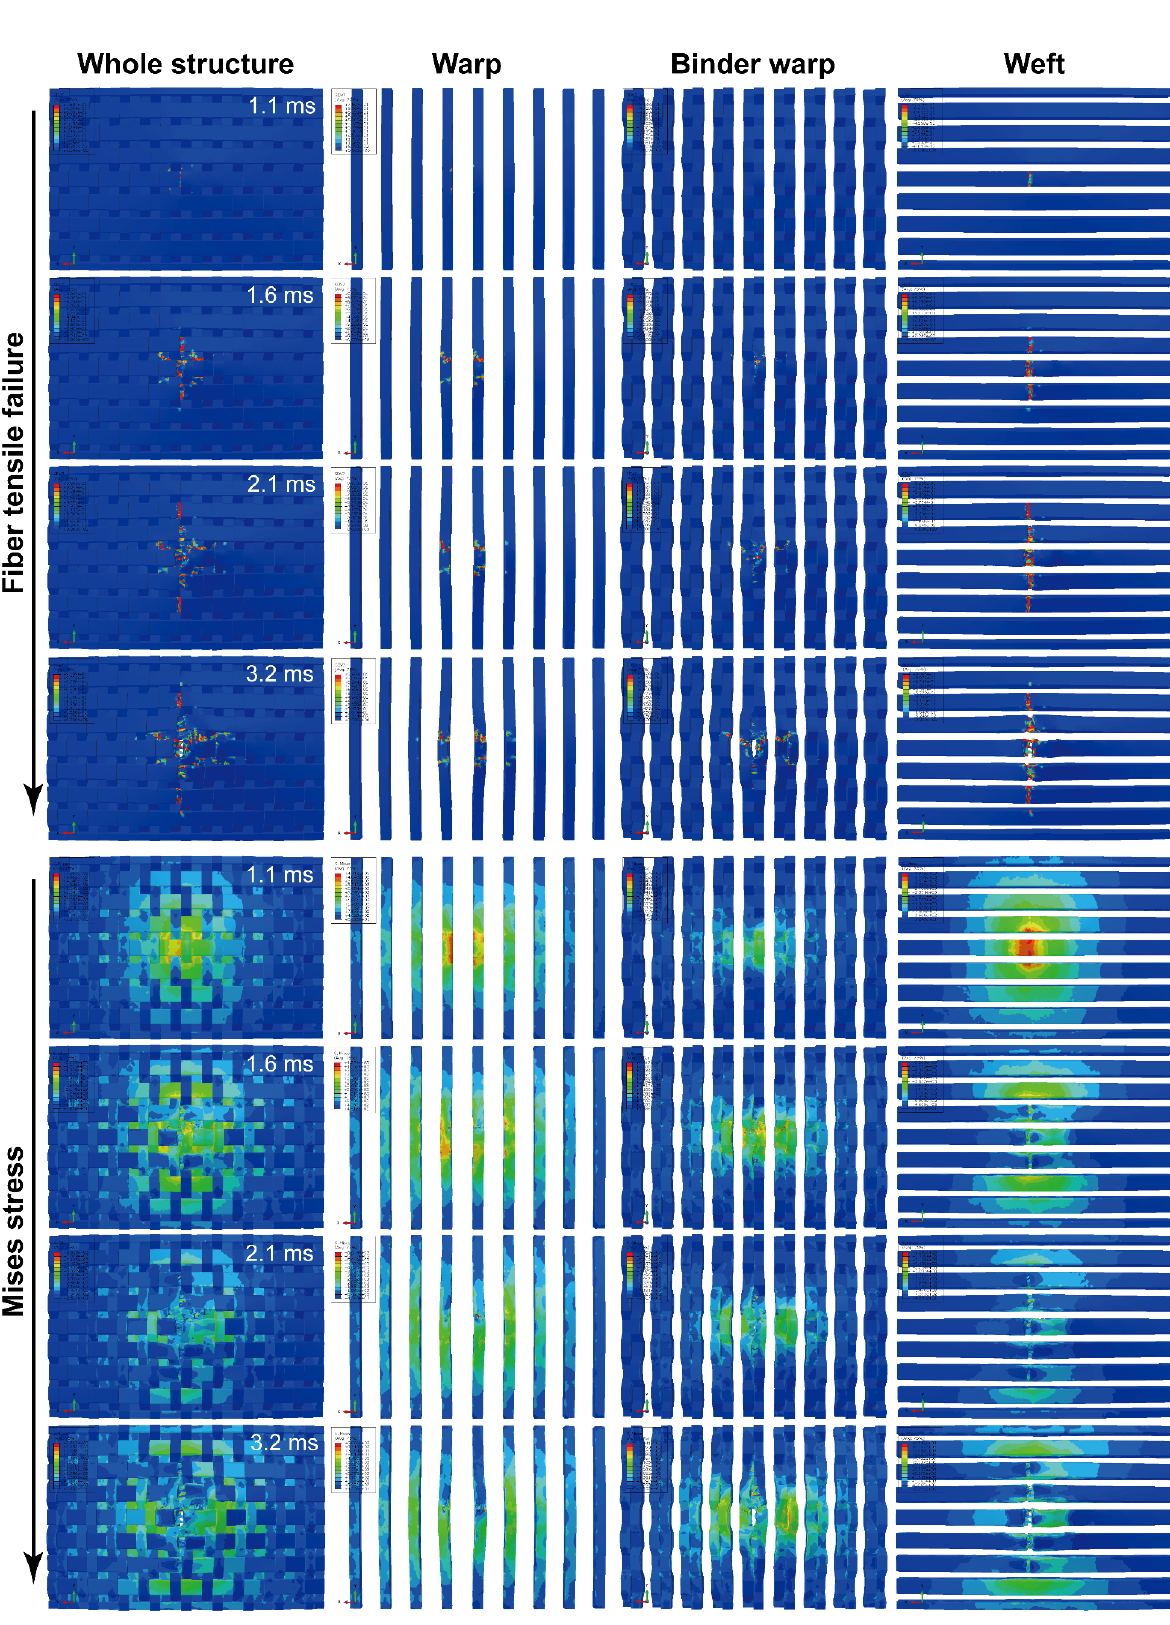
Figure 6. Damage evolutions and corresponding stress distributions of the whole structure and component yarns for a 0° specimen under 47.6 J of impact energy.